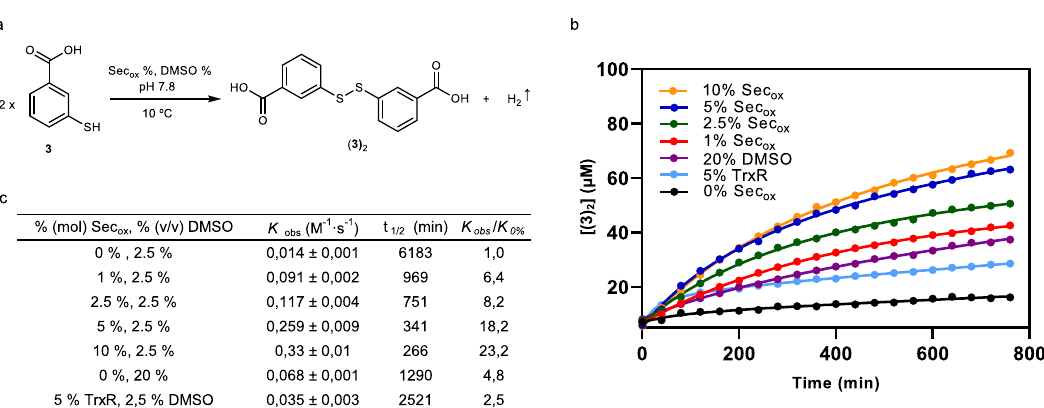
Fig. 6 Kinetic rates to Sec ox . a Homodimerization of building block 3 to ( 3 ) 2 . b Time course for the ( 3 ) 2 formation using a concentration of 190 μ M of ( 3 ), in 20 mM Tris buffer (pH 7.8), T = 6 °C, 0% (mol) Sec ox and 2.5% (v/v) DMSO (black dots), 5% (mol) TrxR and 2.5% (v/v) DMSO (light blue dots), 0% mol Sec ox and 20% (v/v) DMSO (purple dots), 1% (mol) Sec ox and 2.5% (v/v) DMSO (red dots), at 2.5% (mol) Sec ox and 2.5% (v/v) DMSO (green dots), 5% (mol) Sec ox and 2.5% (v/v) DMSO (blue dots) and 10% (mol) Sec ox and 2.5% (v/v) DMSO (orange dots). c Kinetic parameters. Reaction pro fi les were fi tted to second-order reaction kinetic equations. Mean ± SD from three independent experiments. (Supplementary Fig. 38, Supplementary Methods, and Supplementary Discussion). Source data are provided as Source Data fi le.